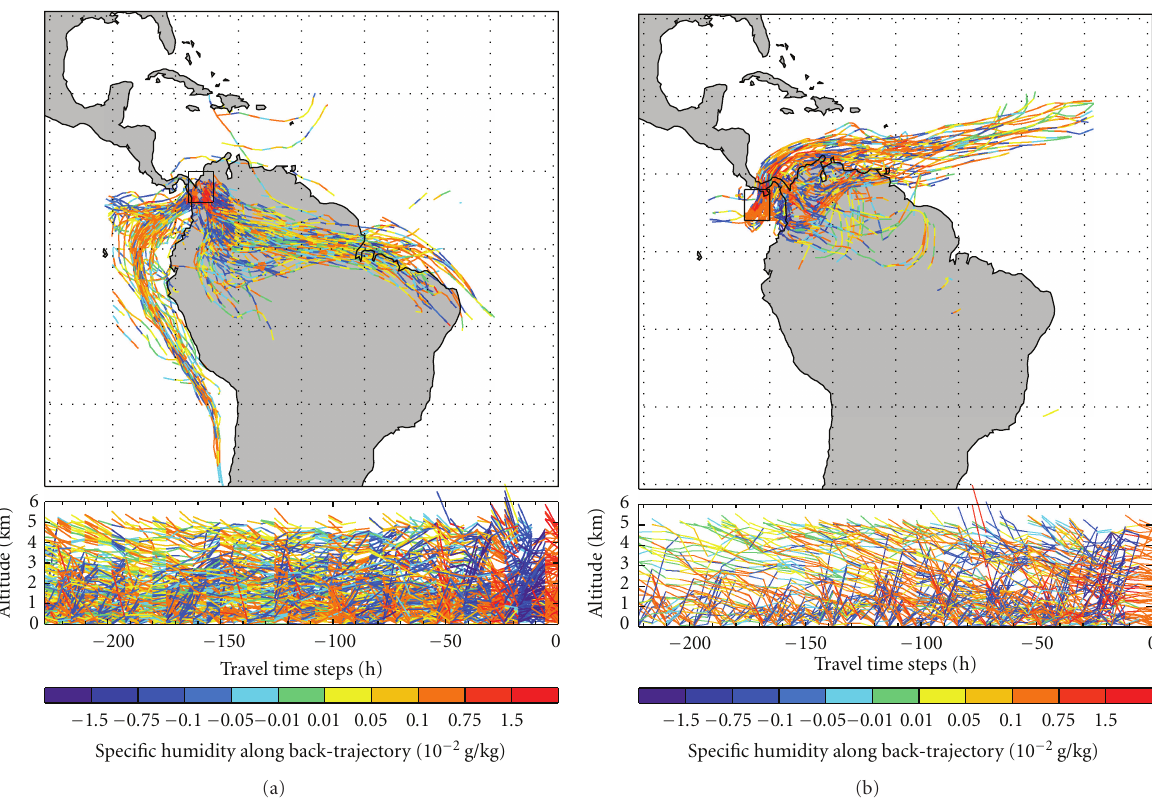
Figure 8: Examples of backward trajectories of moisture particles that contributed to MCS genesis observed: (a) over the continent in 2003/09/23; (b) over the ocean in 2003/01/31. Values of specific humidity are given in 10 − 2